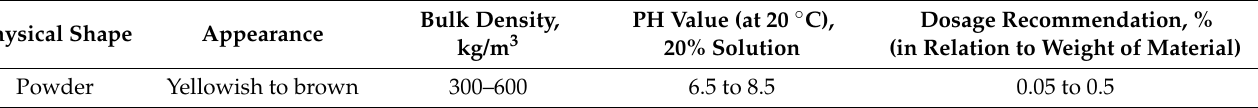
Table 2. Main characteristics of PD.